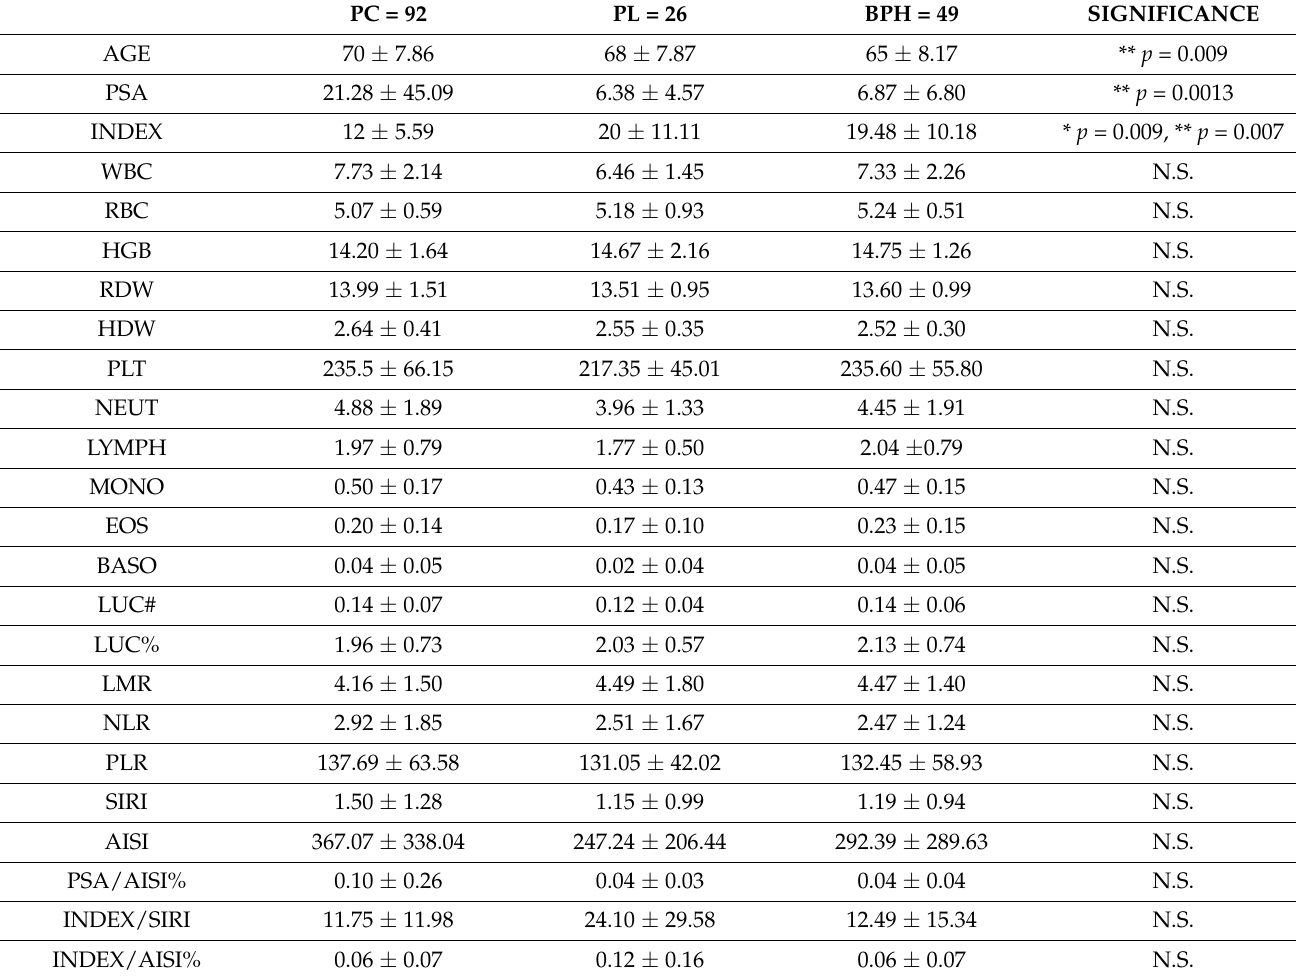
Table 1. List of characteristics from the clinical records of the patients. * PC vs. PL, ** PC vs. BPH. N.S. (not significant): denote a result from a statistical hypothesis-testing procedure that does not allow the researcher to conclude that differences in the data obtained for different samples are